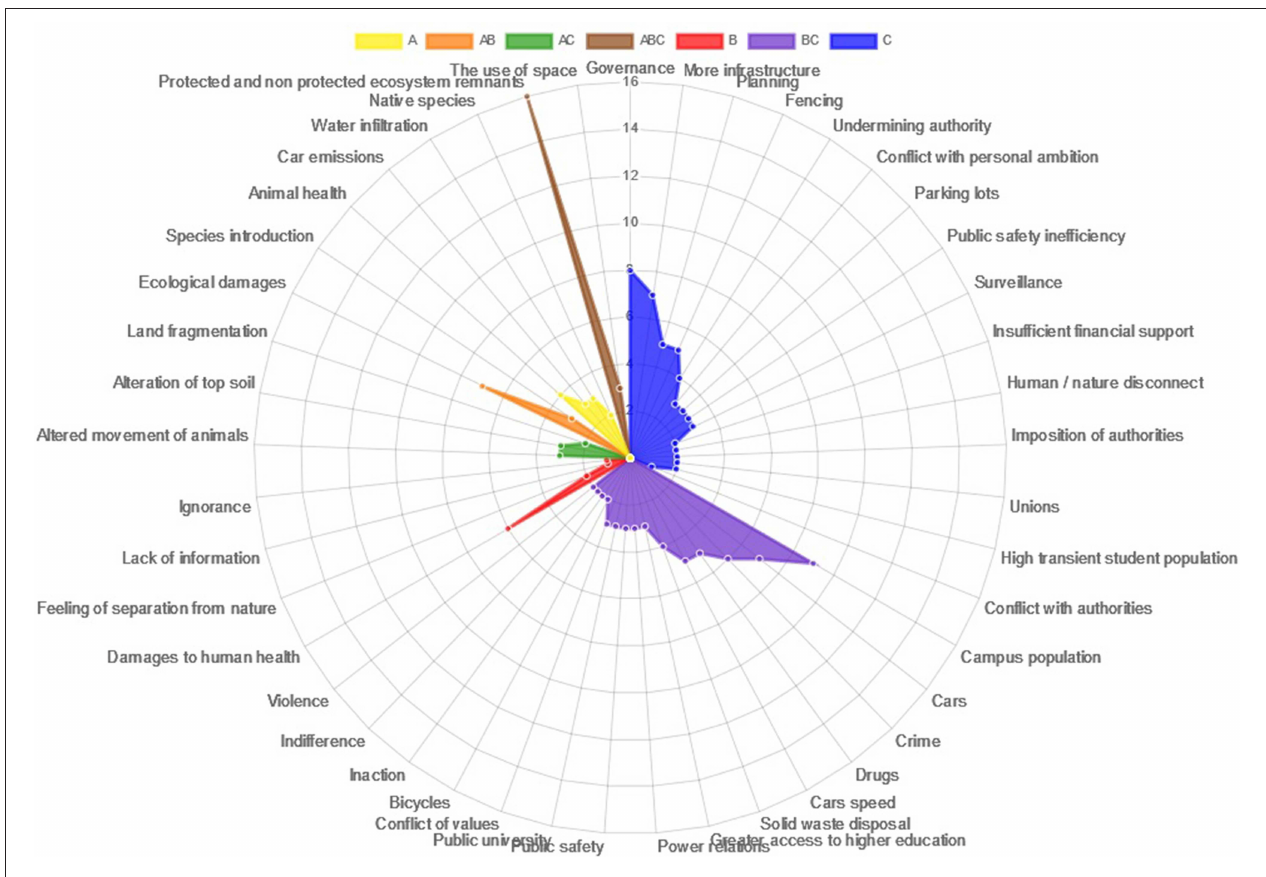
FIGURE 4 | Number of connections for each one of the network components per